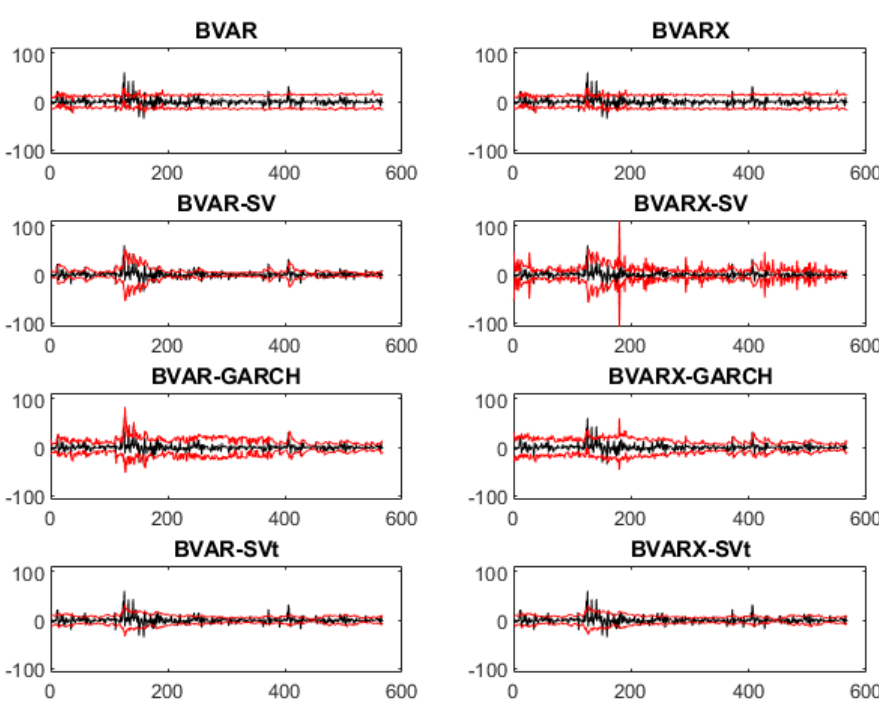
Figure A4. Credible interval for